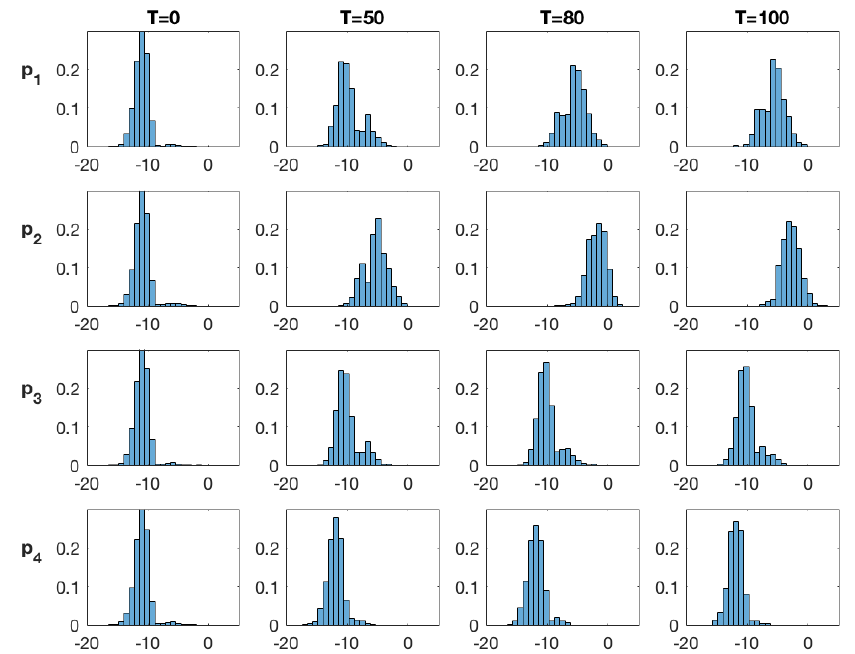
Figure 6. SEnKF approach: Marginal posterior distribution of the log diffusivity f ( log ( λ i ) | d 0: T ) at time T = 0,50,80,100 at the monitoring locations (1,2,3,4) denoted ( p 1 , p 2 , p 3 , p 4